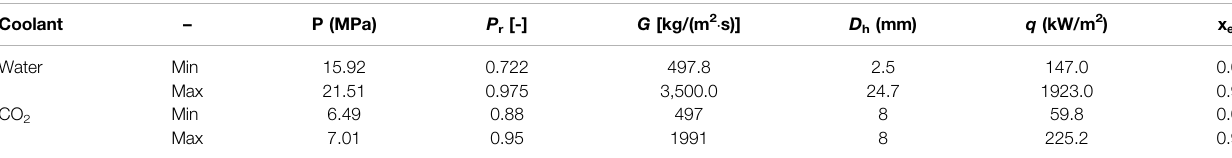
TABLE 5 | Parameter ranges of high-pressure post-CHF heat transfer experiments. Coolant